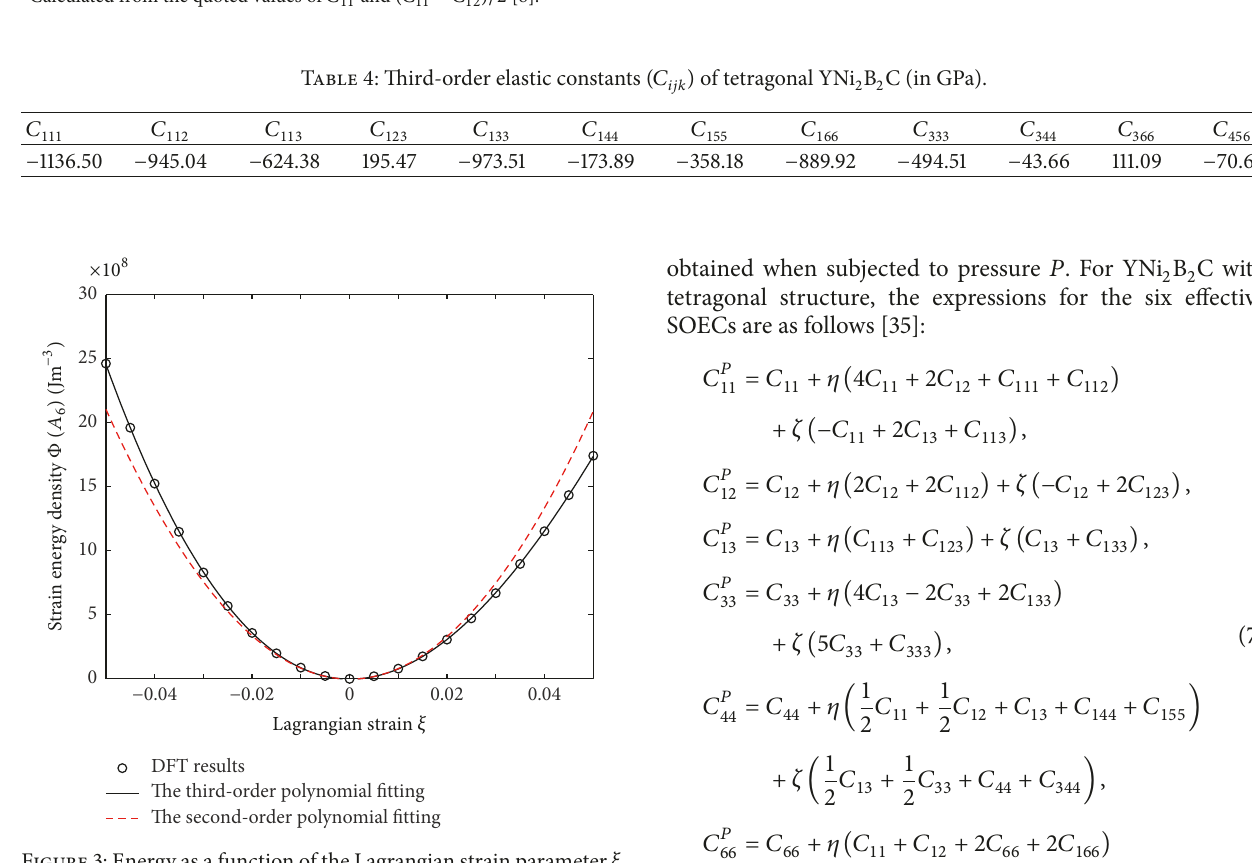
Figure 3: Energy as a function of the Lagrangian strain parameter 𝜉 for the particular strain tensor 𝐴 6 . The circles indicate the values of the first-principles calculations; solid and dashed curves represent the results obtained from nonlinear and linear elasticity theory,